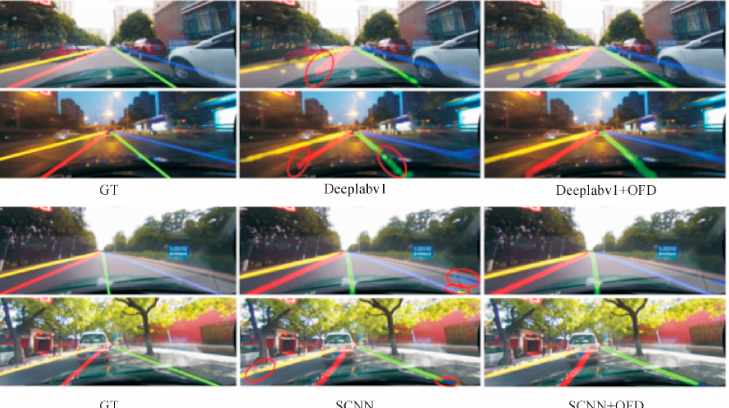
Figure 7. Lane line detection effect diagram before and after using the target feature distillation method.